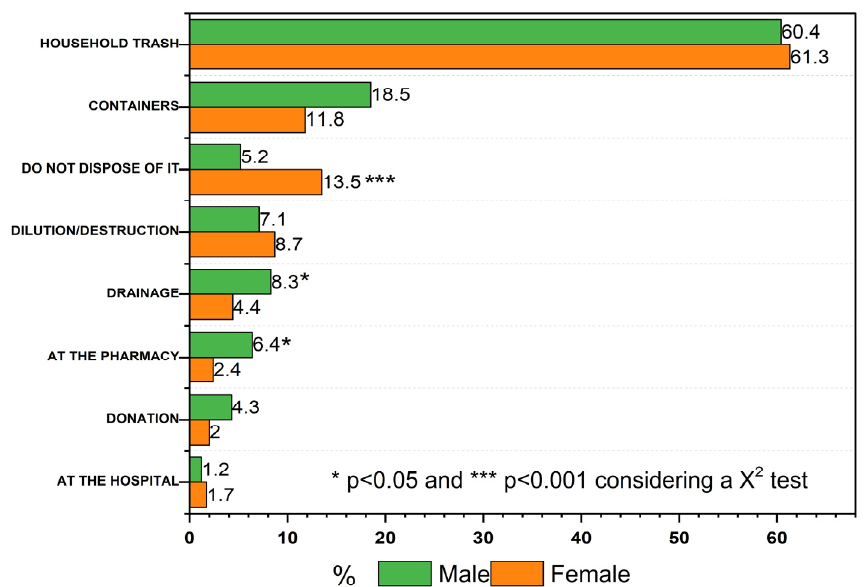
Figure 1. Disposal techniques according to gender. Table 2. Disposal techniques and knowledge of specific containers for the proper handling of medication, according to employment in the health-related